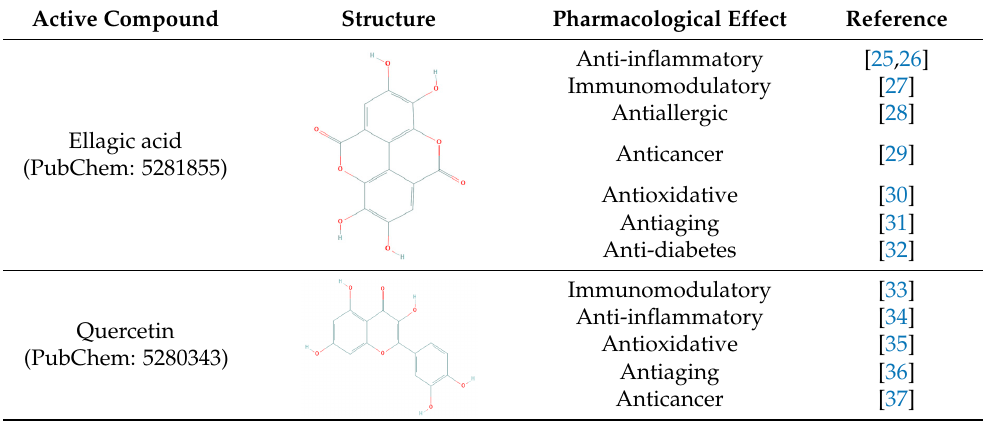
Table 1. Pharmacological effects of active compounds found in the camu-camu fruit. Active compound